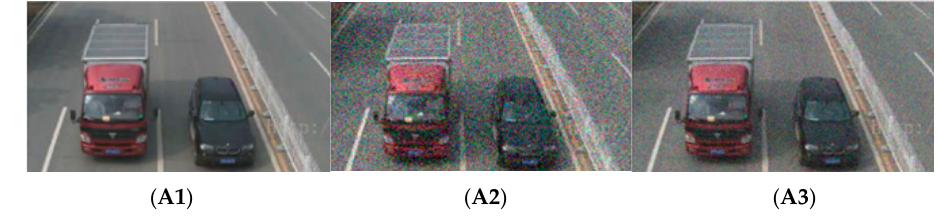
Figure 15. Vehicle images: model performance trained with 180 × 180 image size. ( A1 ) The original image; ( A2 ) the noisy image; ( A3 ) denoised image with σ = 15 .